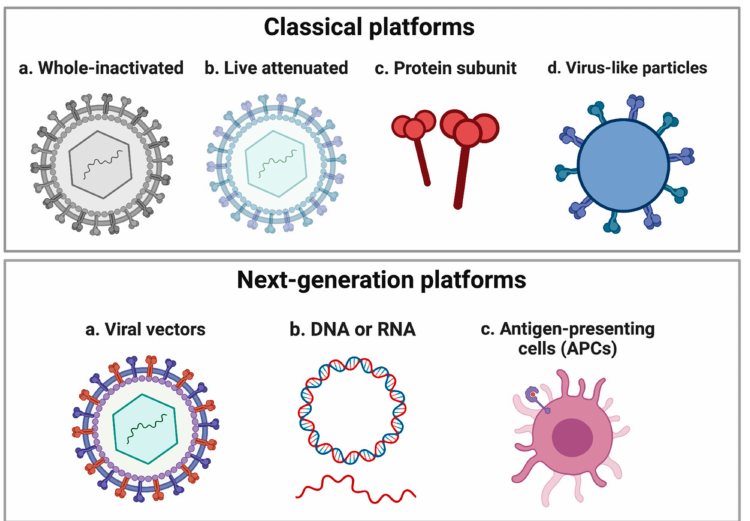
Figure 1. A schematic showing the classical vaccine platforms and next-generation platforms. The classical platforms include whole-inactivated, live attenuated, protein subunit, and virus-like particles (VLPs). The next-generation platforms include recombinant viral vectors, nucleic acid (DNA or RNA), and antigen-presenting cells (APC). Created with